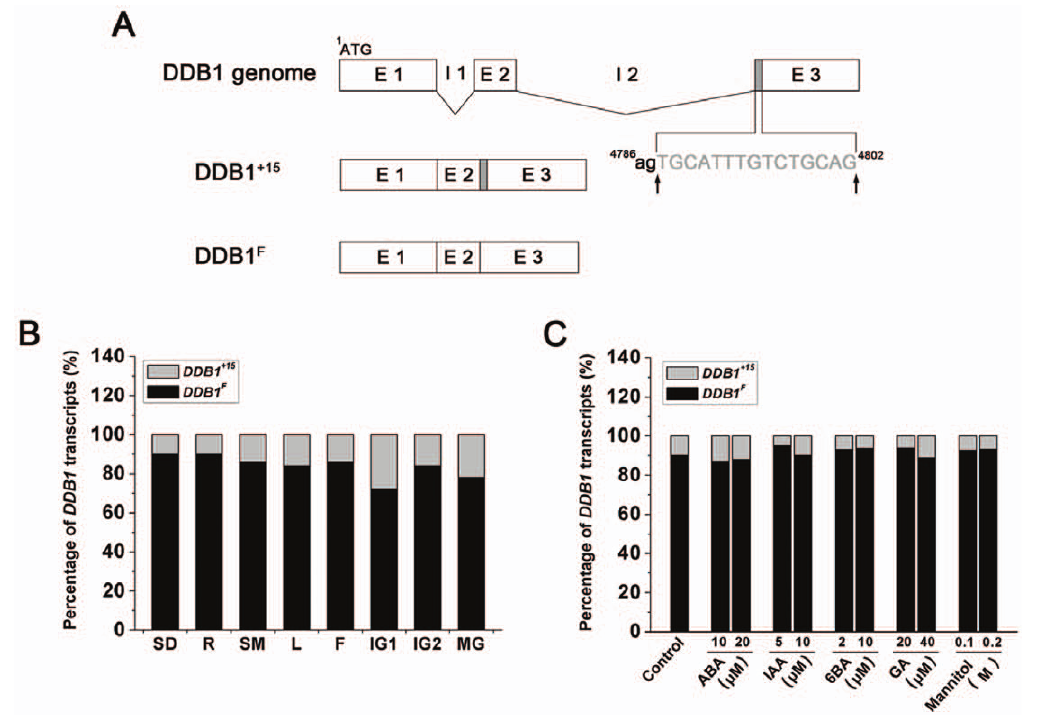
Figure 1. Expression analysis of transcript variants of DDB1 . (A) Schematic diagram of DDB1 gene splicing pattern. Introns (I) and exons (E) are marked by lowercase and uppercase letters, respectively. Numbers above the letter and arrows indicate the position of the nucleotide in the genome sequence and the site of alternative splicing, respectively. The extra 15 bp nucleotides of DDB1 + 15 transcript are shown in grey. (B) The percentage of two DDB1 transcripts in different tissues. SD: seedlings; R: roots; SM: stems; L: leaves; F: flowers; IG1: immature green fruits at 7-DPA; IG2: immature green fruits at 14-DPA; MG: mature green fruits at 35-DPA. The light gray and black bars indicate the expression percentage of the DDB1 + 15 and DDB1 F transcripts, respectively. Data presented are the means of three technical replicates. Similar results were obtained in at least two independent experiments. (C) Identification of the percentage of two DDB1 transcripts in seedlings under hormones or stress treatment. Total RNAs were extracted from 10-day-old seedlings with application of abscisic acid (ABA), auxin (indole acetic acid; IAA), cytokinin (6-benzylaminopurine, BA), gibberellins (GA) and mannitol. 10-day-old seedlings without any hormone and stress treatment were used as control. The light gray and black bars indicate the expression percentage of the DDB1 + 15 and DDB1 F transcripts, respectively.